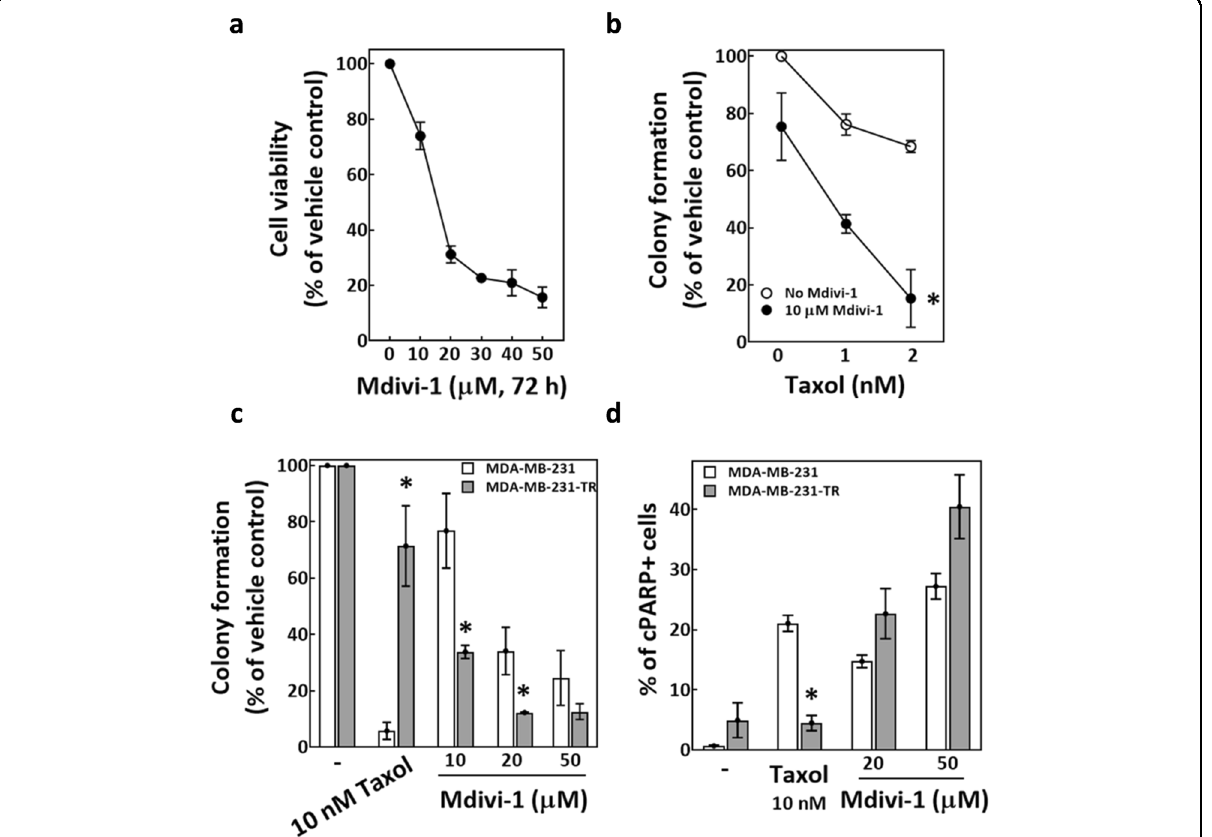
Fig. 1 Mdivi-1 enhances cytotoxicity of taxol and overcomes taxol resistance in MDA-MB-231. a Cytotoxicity of mdivi-1 in MDA-MB-231 cells. Cells were treated for 72 h with mdivi-1 at the indicated concentrations and then subjected to trypan blue exclusion assay. The percentages of cell viability relative to the vehicle control are shown as mean ± SD from at least three independent experiments. b Mdivi-1 enhanced the cytotoxicity of taxol. Cells were treated either with taxol alone or in combination with mdivi-1 at the indicated concentration for 24 h and then subjected to colony formation assay. The percentages of colonies formed compared to the vehicle control are shown as mean ± SD from four independent experiments. * p < 0.05 comparing 10 μ M mdivi-1-treated groups to no mdivi-1-treated groups by two-way ANOVA. c and d The taxol-resistant MDA-MB-231-TR cells remained sensitive to mdivi-1. MDA-MB-231 and the resistant MDA-MB-231-TR cells generated as described were treated as indicated for 24 h and then used in the colony formation assay ( c ) or cells were treated for 72 h and subjected to fl ow cytometry analysis for cleaved-PARP-positive (cPARP + ) cells ( d ). The percentages of colonies formed relative to vehicle control and percentages cPARP + cells are shown as mean ± SD from three independent experiments. * p < 0.05 comparing MDA-MB-231-TR to MDA-MB-231 by Student ’ s t